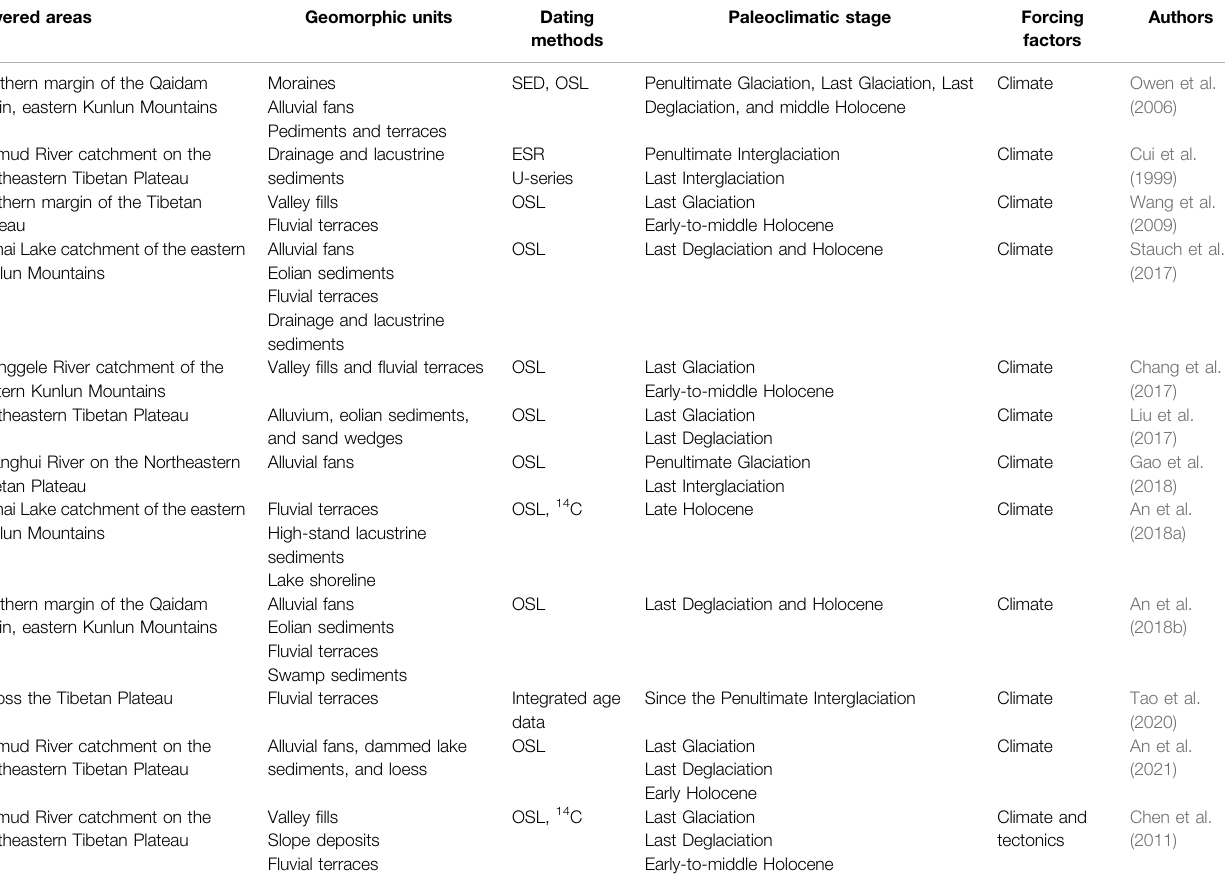
TABLE 2 | Statistics of climatic/tectonic forcing factors for various geomorphic units from previous studies in the Northeastern Tibetan Plateau since 200 ka. Covered